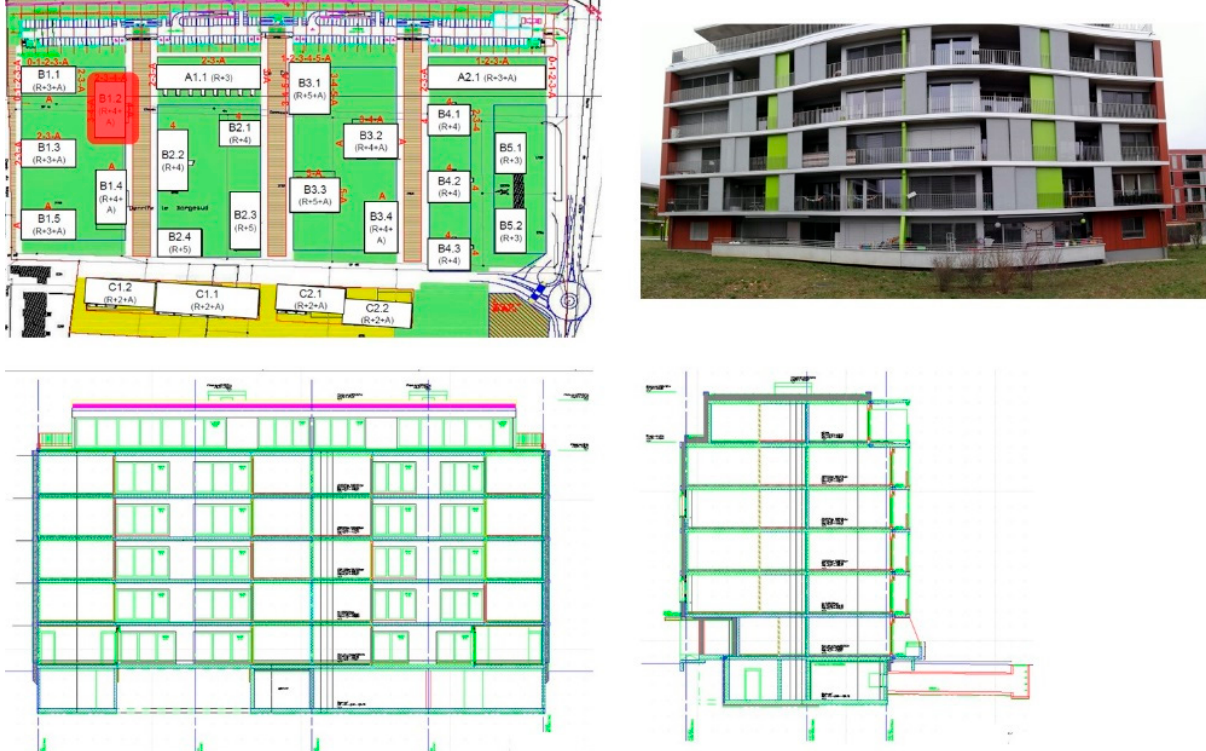
Figure 2. Different views of the building case study in Gland and its position to the ecological district, marked in red.